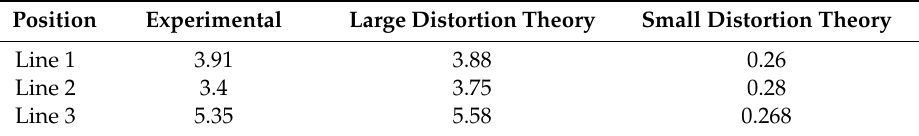
Table 7. Di ff erences between large and small distortion theory